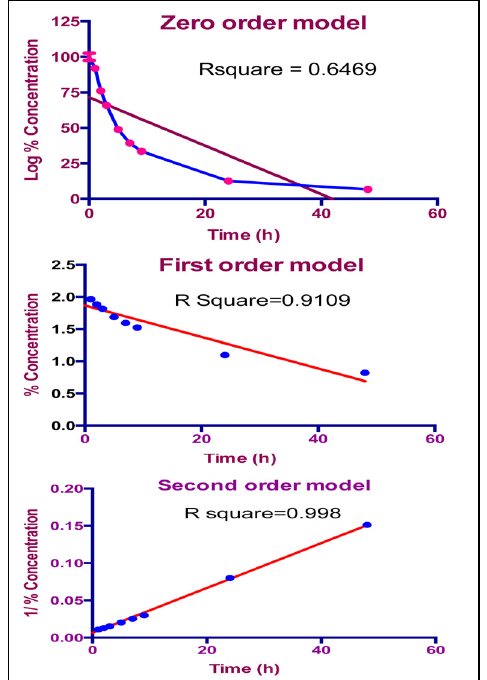
Figure 6. TQ Light degradation kinetics plotted for zero, first and second order